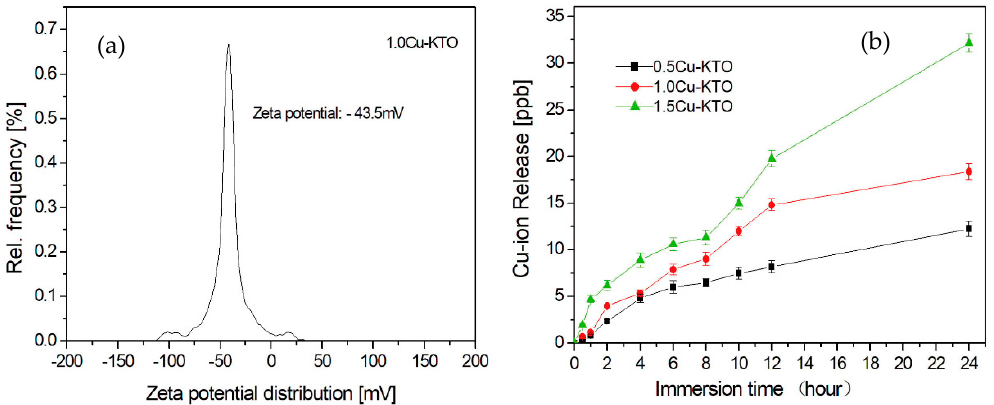
Figure 8. Zeta potential characteristics of 1.0 Cu–KTO dispersed in deionized water ( a ) and the amount of Cu ion release for 0.5, 1.0 and 1.5 Cu–KTO with respect to immersion time ( b ).